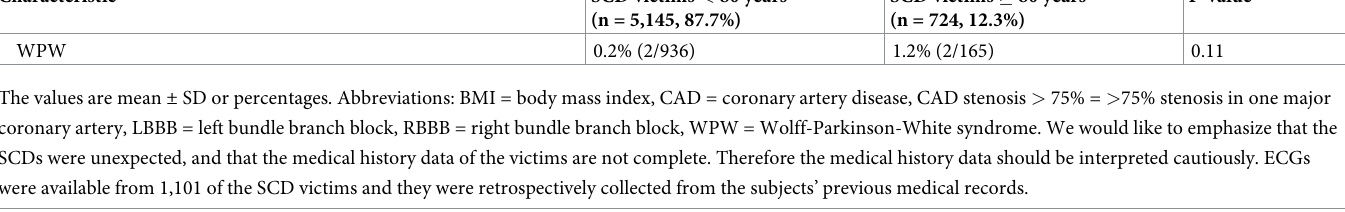
victims aged < 80 years. However, even in victims � 80 years, the average heart weight was higher than the criteria used for cardiomegaly in the study by Roberts and Shirani ( > 350 g in females, > 400 g in males) (7) (Tables 1 and 3). The proportion of females was higher and the body weight was lower in SCD victims aged � 80 years than victims aged < 80 years. (Table 1). Heart weight, liver weight, and abdominal fat thickness had significant correlations with the body weight (p < 0.001, the Pearson correlation coefficients: 0.619, 0.641, 0.688, respectively). All of these characteristics were also lower among nonagenarians than among octogenarians, as was the frequency of the occurrence of fatty liver (P = 0.02) (Table 2). In addition, having fatty liver (P < .001) or liver cirrhosis (P < .001) was significantly less fre- quent among SCD victims aged � 80 years than among those aged < 80 years. On the con- trary, having severe fibrosis in myocardium (P < .001) was more frequent in those � 80 years than in those < 80 years (Table 1, Fig 3). Female SCD victims aged 80 years or more had higher BMI (P < .001) and more abdominal fat (P < .001) than male ones in the same age group, whereas male’s heart (P < .001) and liver weight (P < .001) was greater than that